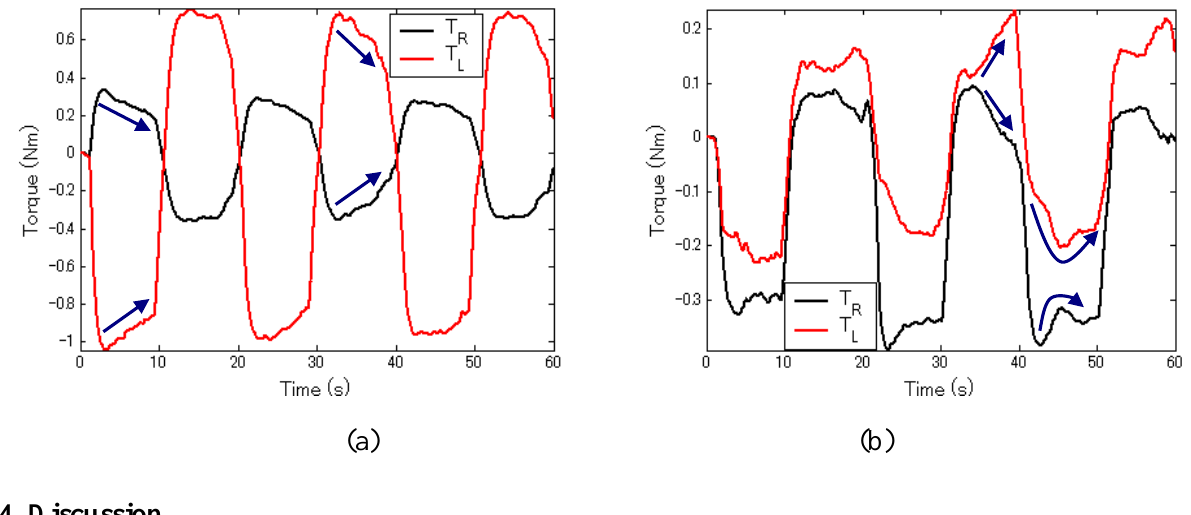
Figure 8. Torque curves in the two terminals. (a) Active-resisted mode. (b) Active-assisted